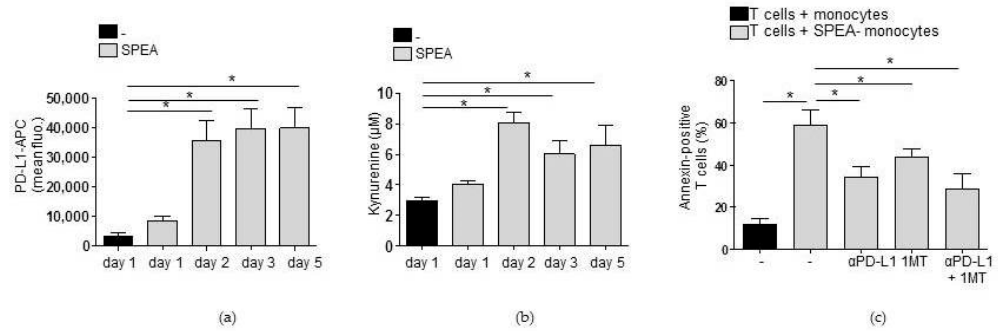
Figure 6. Apoptosis of T cells in SPEA-monocyte / T-cell coculture is mediated by PD-L1 and IDO. ( a , b ) Primary monocytes were stimulated with 1000 ng / mL SPEA untreated. After 48 h, cells were washed and T cells were added. On days 1 and 2 (before coculture) and on days 3 and 5, cells were analyzed. ( a ) Antibody staining was performed with anti-PD-L1-APC antibody. Fluorescence was analyzed on a FACSCanto. Shown is the mean fluorescence of the APC signal of the gated monocyte population. ( b ) Supernatant of cultures was used for the detection of kynurenine. ( c ) Monocytes were stimulated with 1000 ng / mL SPEA for 48 h or left unstimulated. Additionally, cells were treated with the IDO inhibitor 1MT (240 µ M, 1 h prior to SPEA-stim.), anti-PD-L1 antibody (10 µ g / mL, after the start of coculture) or both as indicated in the graph. After two days, cells were washed, anti-PD-L1 antibody was supplemented, and allogeneic CFSE-labeled CD4 + T cells (ratio 1:2) were added. After five days, cells were stained with annexin-FITC and the gated lymphocyte population was analyzed on a FACSCanto. Shown is the percentage of annexin-positive (apoptotic) T cells. ( c ) Black columns: T cells cultured with unstimulated monocytes. Grey columns: T cells cultured with SPEA-monocytes, treated as indicated. Columns depict the mean + SD, n = 3. ( a , b , c ) Statistical analysis: the comparison of two data groups was analyzed by Mann–Whitney U test with * p ≤ 0.05. Kruskal–Wallis: ( a ) number of groups: 5; p -value 0.0255; sum value, * the medians vary significantly ( p < 0.05); ( b ) number of groups: 5; p -value 0.0241; sum value, * the medians vary significantly ( p < 0.05); ( c ) number of groups: 5; p -